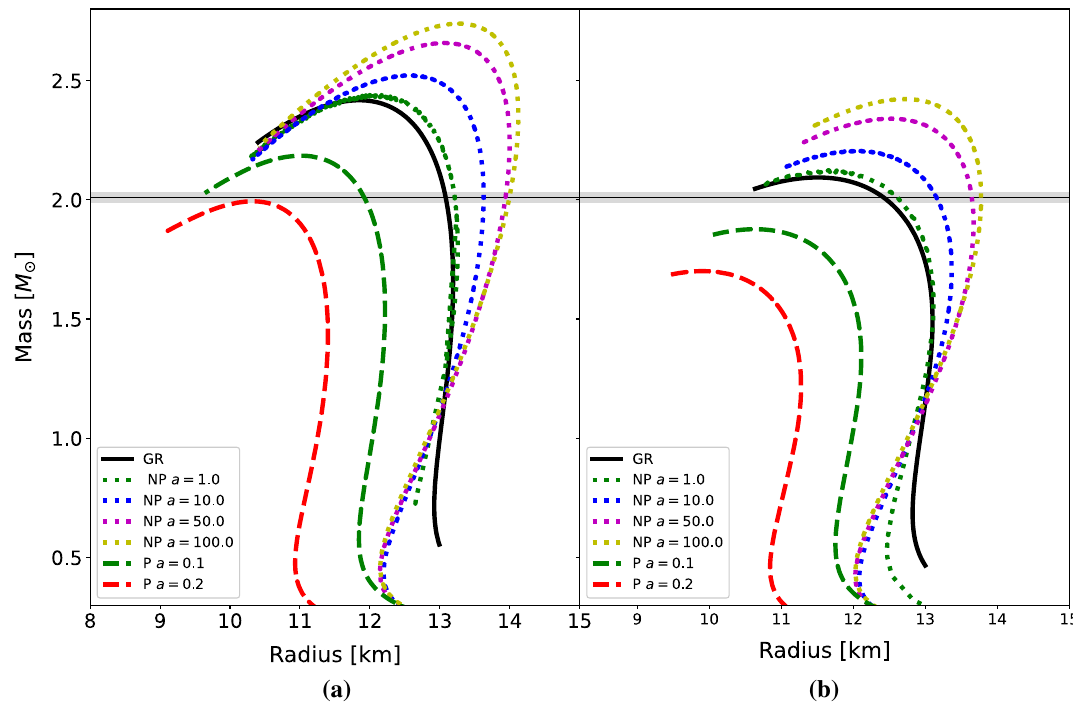
Fig. 2 a MR curves of EoS DD2 obtained using both perturbative (dashed lines) and non-perturbative (dotted lines) methods. b MR curves of EoS BH B (cid:2)φ obtained using both perturbative (dashed lines) and non-perturbative (dotted lines) methods